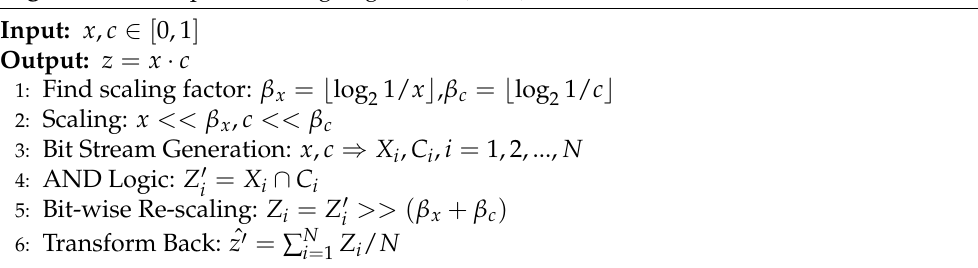
Algorithm 1 Adaptive Scaling Algorithm